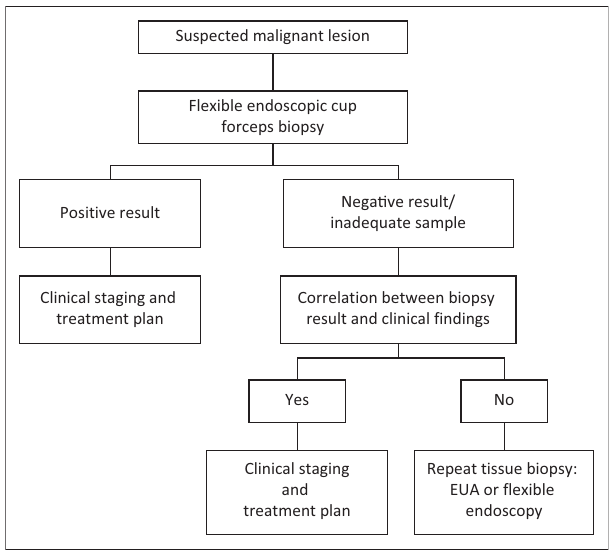
FIGURE 2: Algorithm for tissue sampling of suspected malignant laryngopharyngeal lesions.